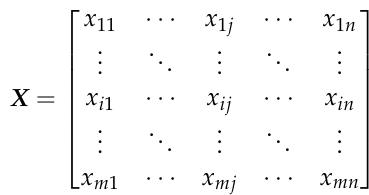
Figure 4. Flowchart of the fuzzy comprehensive evaluation method.